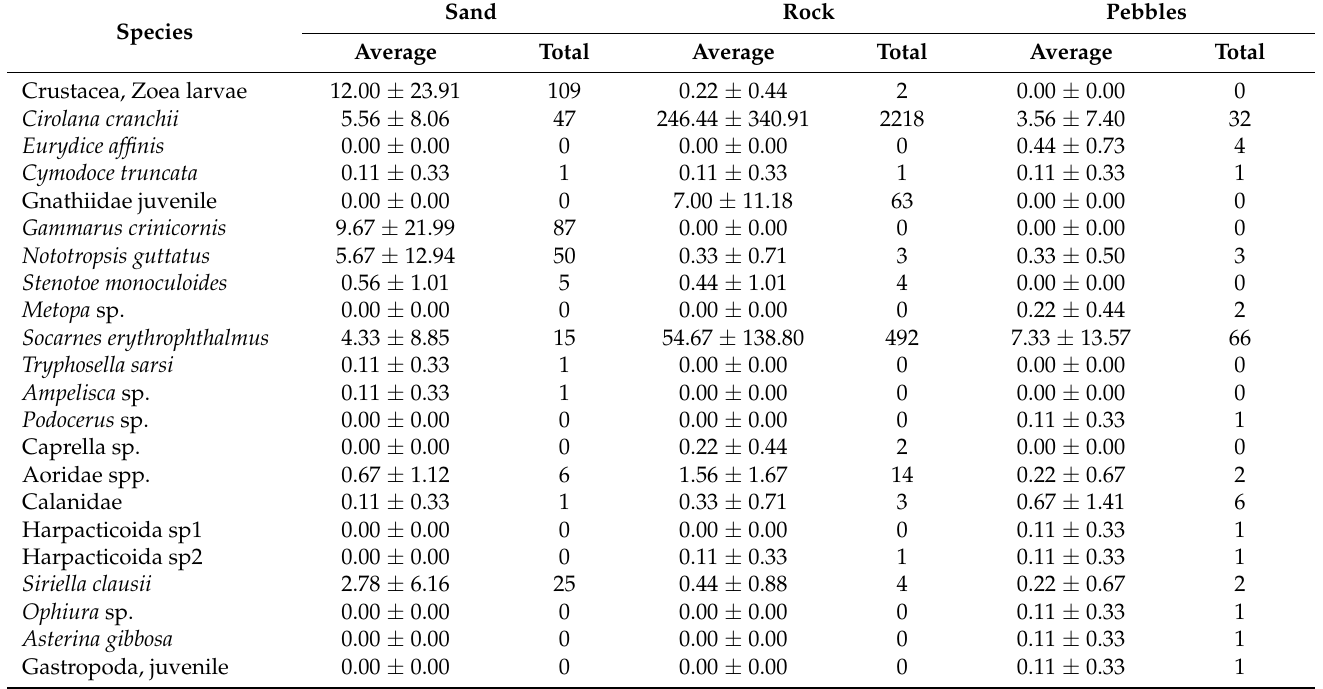
Table 5. Summary of the number of individuals of each benthopelagic macrofaunal species per habitat. Average and standard deviation per trap and the total number of individuals